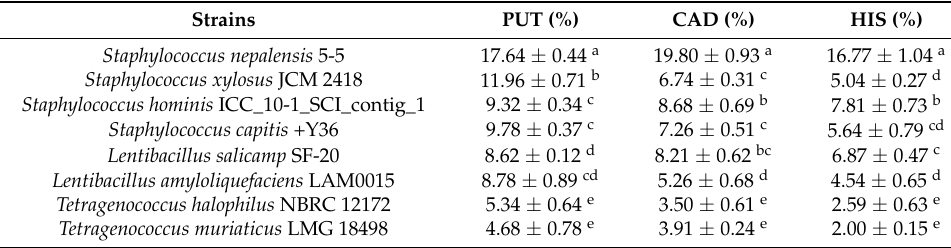
Table 3. Percentage of strains with BA reduction